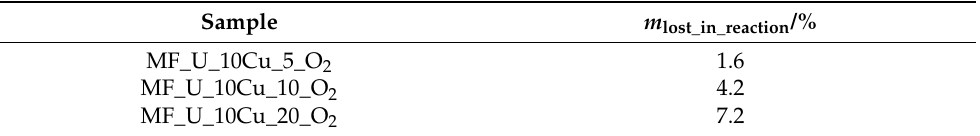
Table A1 presents the catalyst mass lost during the reaction with MF_U_10Cu in the presence of 5, 10 and 20% of O 2 . Table A1. Catalyst mass lost during the reaction in the presence of MF_U_10Cu samples under 5, 10 and 20% O 2 .